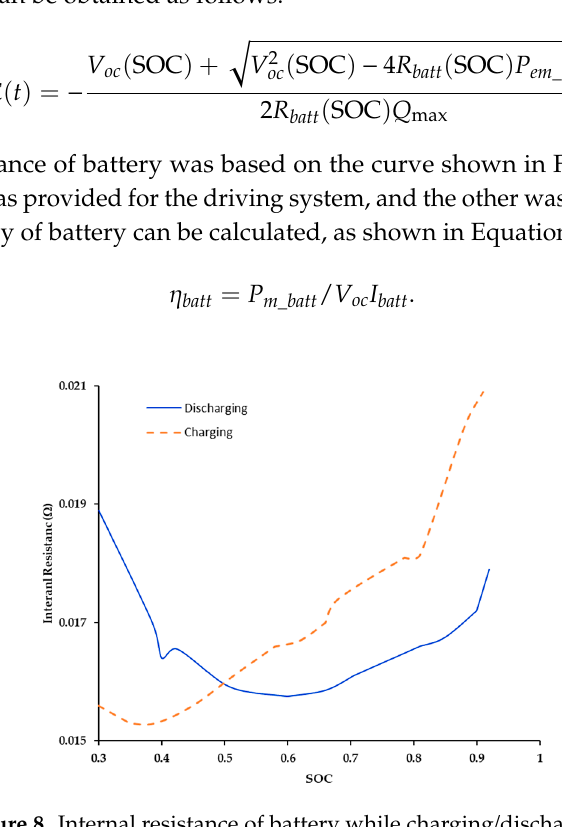
Figure 8. Internal resistance of battery while charging/discharging.